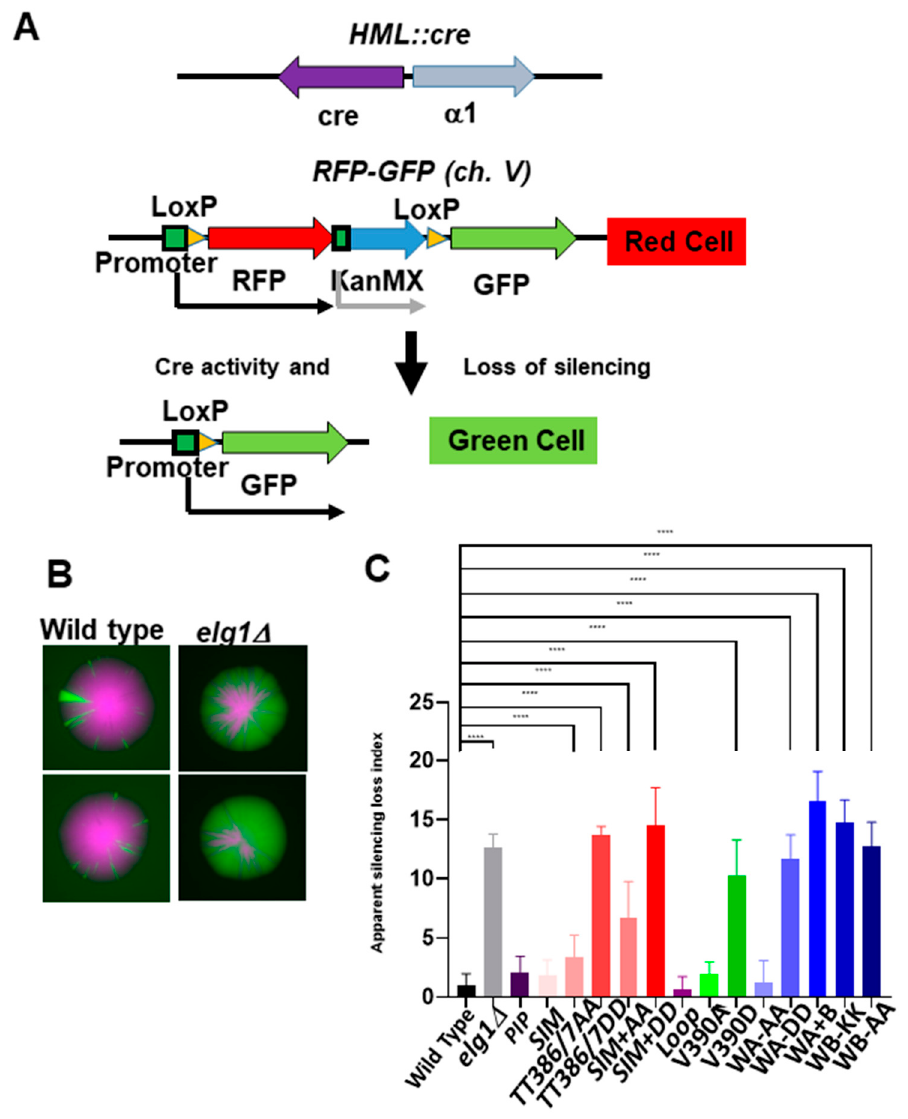
Figure 5. The apparent silencing-loss rates of the different elg1 mutations. ( A ) Schematic descrip- tion of the CRASH assay. ( B ) Colony sectoring of wildtype and elg1 ∆ alleles. ( C ) Genomic versions of the elg1 allele collection were created in CRASH-containing strains. Cre activity was quantified using flow cytometry, as described in Materials and Methods. **** p < 0.0001 was calculated using ANOVA and Dunnett’s test post-hoc analysis.